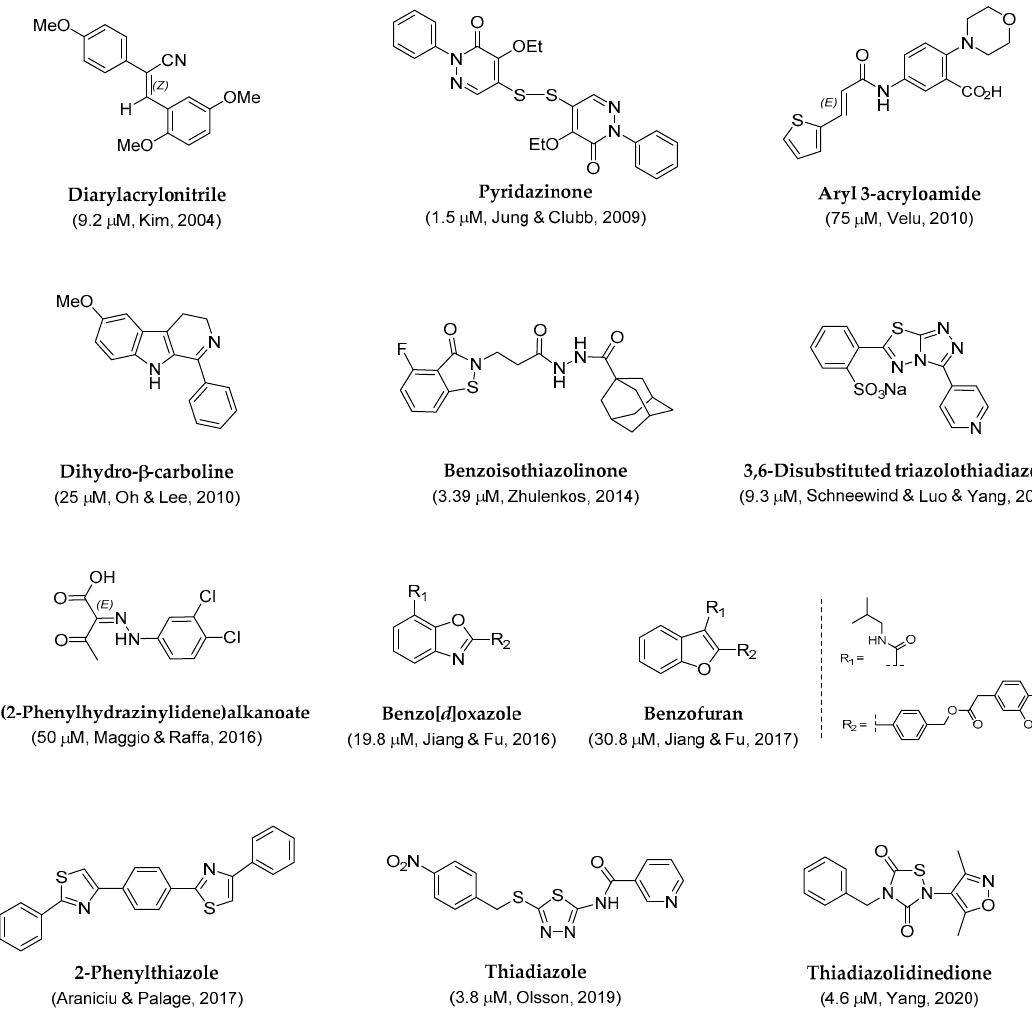
Figure 2. Synthetic small organic molecules as SrtA inhibitors (IC 50 values are given in parentheses) .